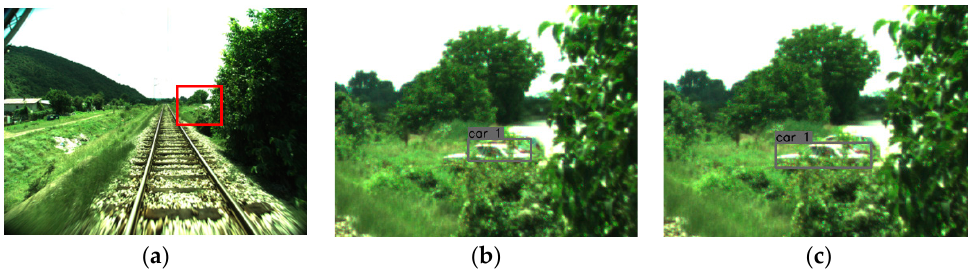
Figure 6. Example of improved object bounding box coordinates. ( a ) Original image with marked region containing the considered object (red rectangular). ( b ) Magnified predictions of Model 1. ( c ) Magnified predictions of Model 2.